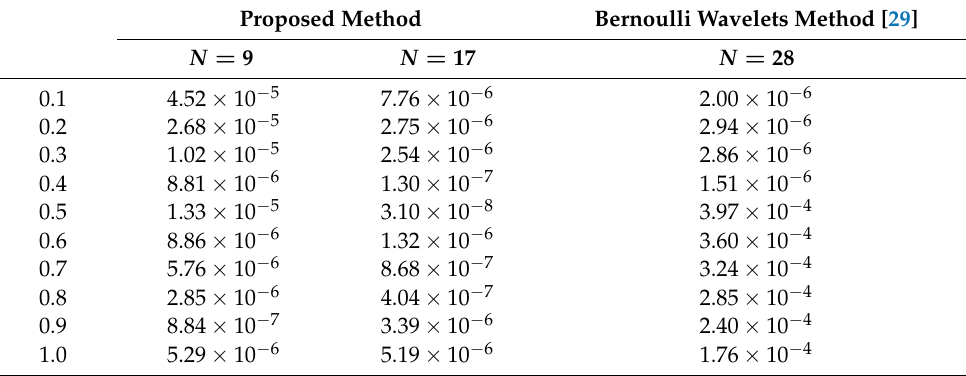
Table 1. The comparison between the proposed method and the Bernoulli wavelets method [29], taking β = 0.8 for Example 1.